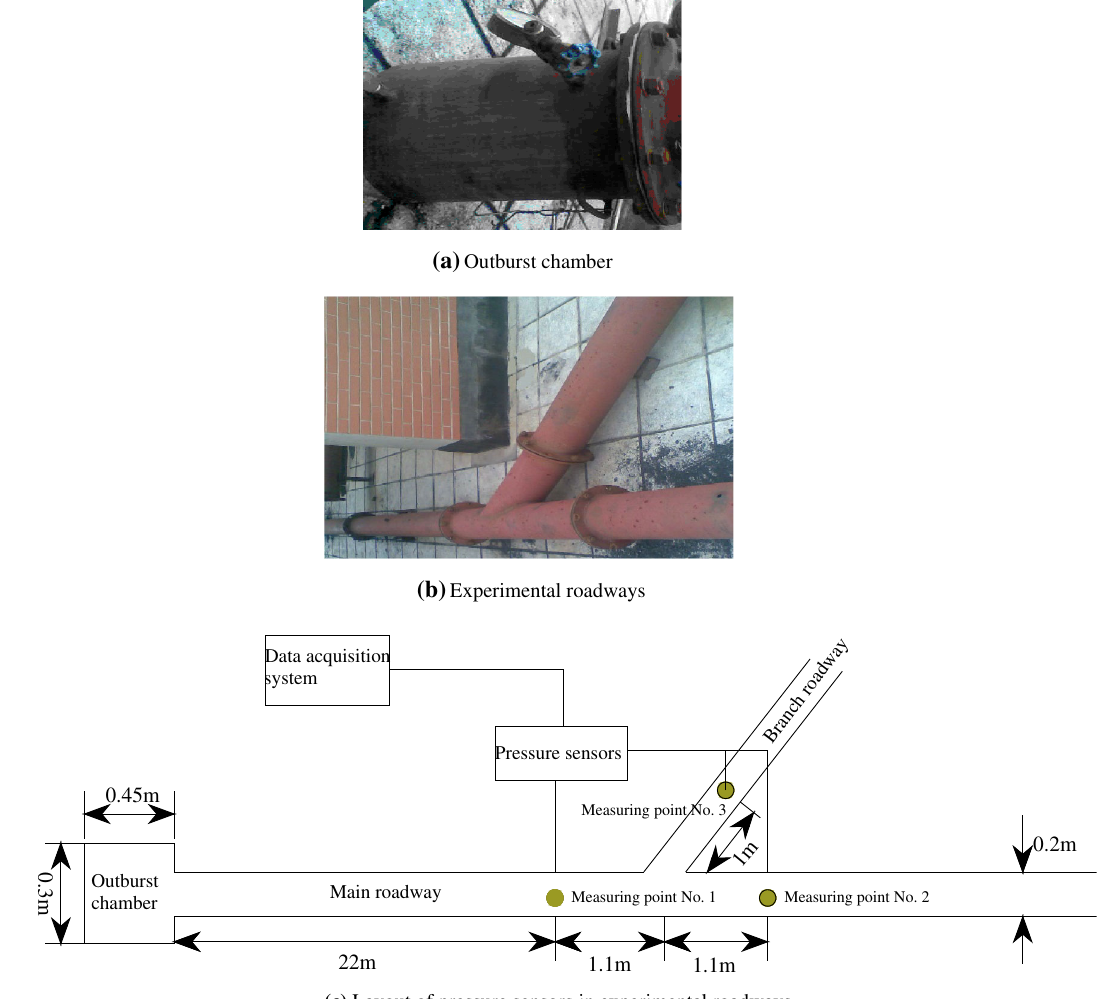
Fig. 16 Experimental devices for simulating shock waves of